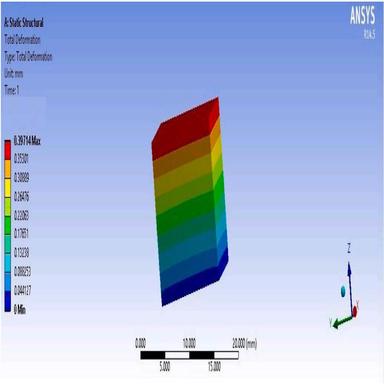
Total deformation of Citrus limetta peel powder composites on compression specimen.